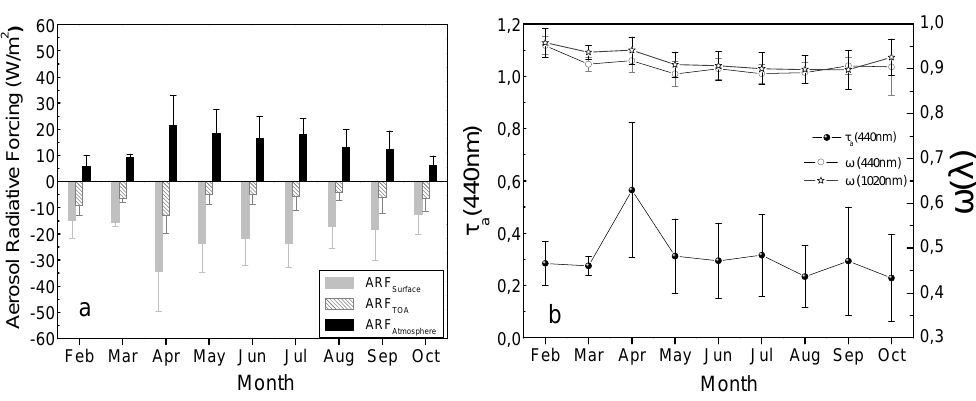
Fig. 7. (a) Monthly mean values of aerosol radiative forcing at TOA, surface and in the atmosphere during desert dust events at Granada during 2005–2010. (b) Monthly mean aerosol optical depth at 440nm and single scattering albedo at 440nm and 1020nm. The error bars correspond to standard deviation Table 4. Daily aerosol radiative forcing (Wm − 2 ) and daily aerosol radiative forcing efficiency (Wm − 2 ) at surface, TOA and in the atmo- sphere observed over different locations during desert dust events. The second column ( λ) indicates the spectral range considered and third column shows the surface albedo (A) used in each study.